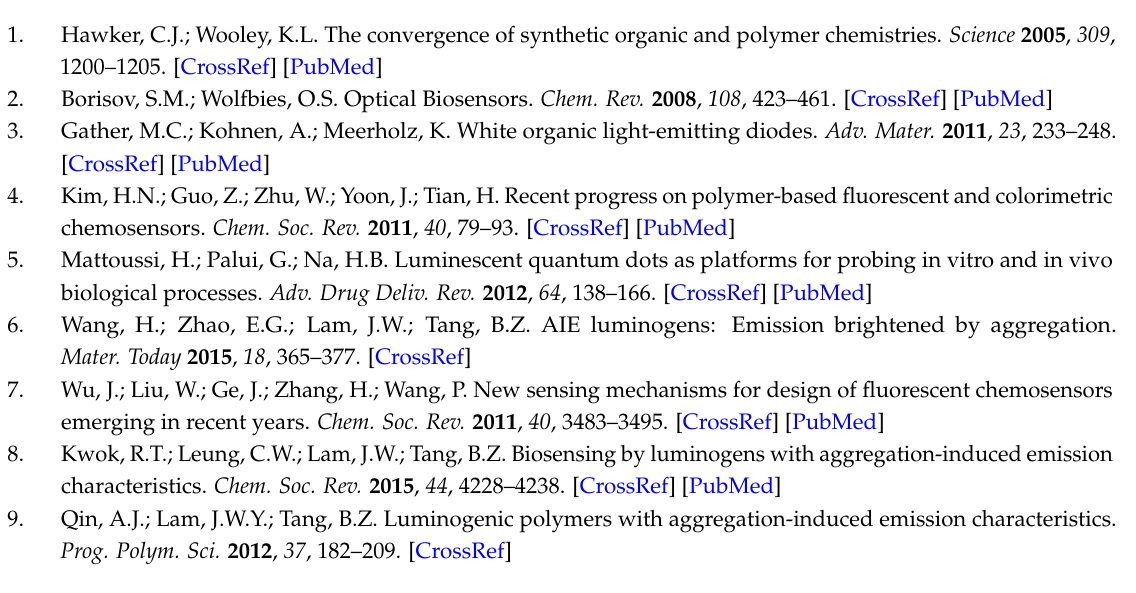
(B) poly(AS- alt -MIPOSS-NHBu) in THF/H2O at various ratios, at a concentration of 10–4